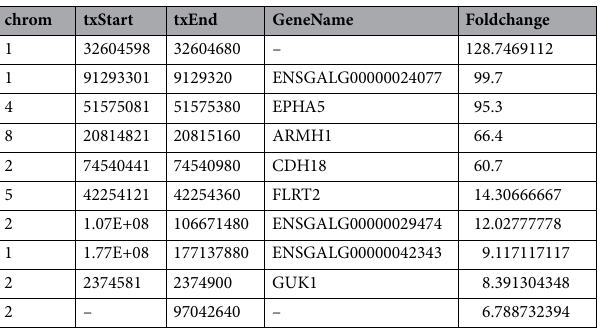
Table 1. Top ten up-methylated peaks of differentially m 6 A methylated sites in the infected group. “–” represents not available . Chrom: Chromosome; TxStart/TxEnd: Start/end position of the differentially methylated RNA peaks.